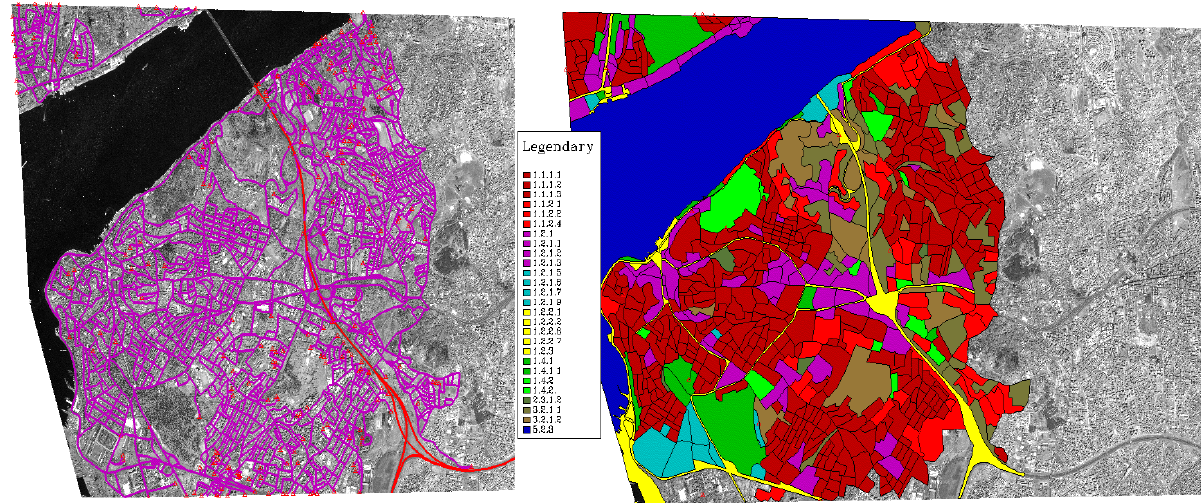
Figure 1: Example of the digitised transportation network on the left (Highways in red, other road in pink) and the lad-use data set on the right with the legendary of the classes (red = residential, pink =